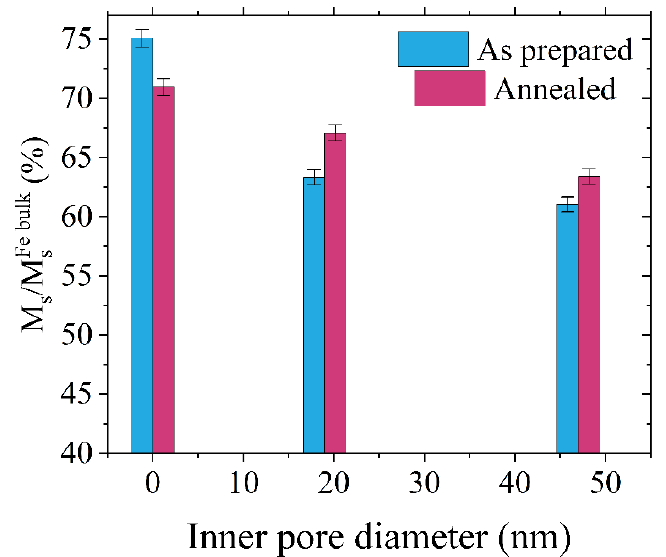
Figure 5. The saturation magnetization dependence on pore size for as-prepared and annealed samples. Bars show the comparison of the saturation magnetization of Fe/ATiO system to the saturation magnetization of bulk Fe.